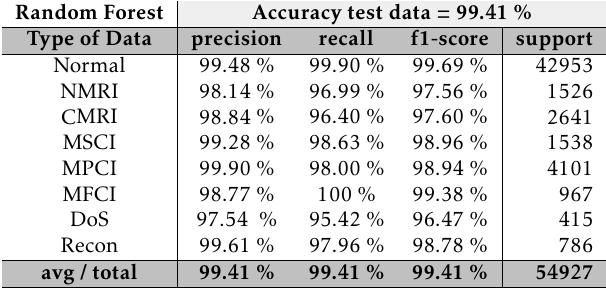
Table 8. Classification report of the RF algorithm.